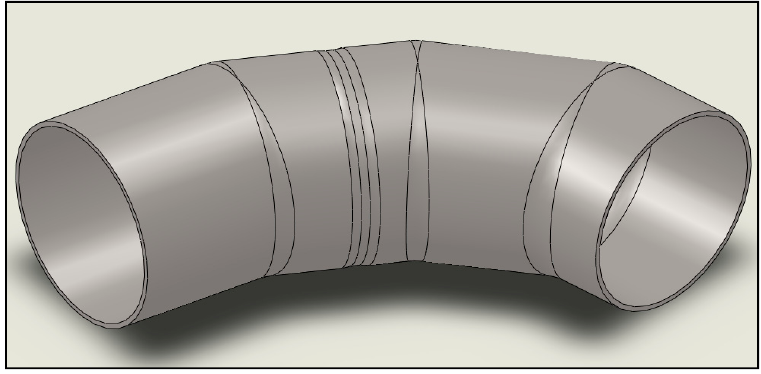
Figure 16. Geometrical modeling.